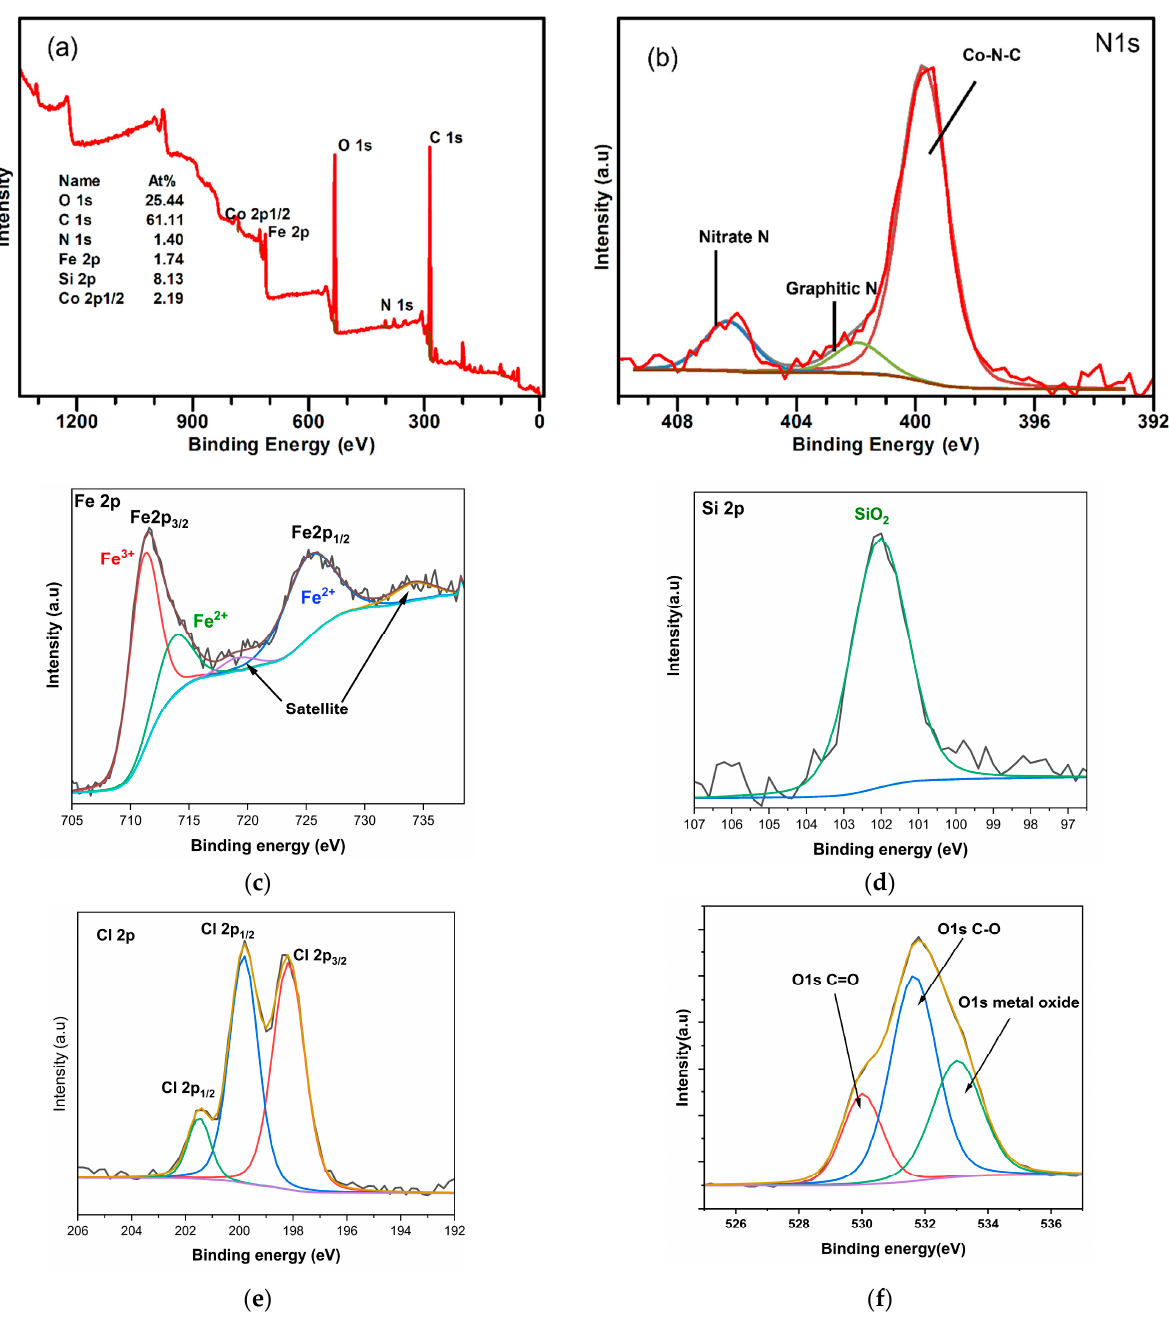
Figure 6 . ( a ) Survey of Fe 3 O 4 @C1 catalyst, ( b ) The N 1s high-resolution spectrum and analysis for Fe2p ( c ), Si 2p ( d ), Cl2p ( e ) and O1s ( f ) elements in Fe 3 O 4 @C1